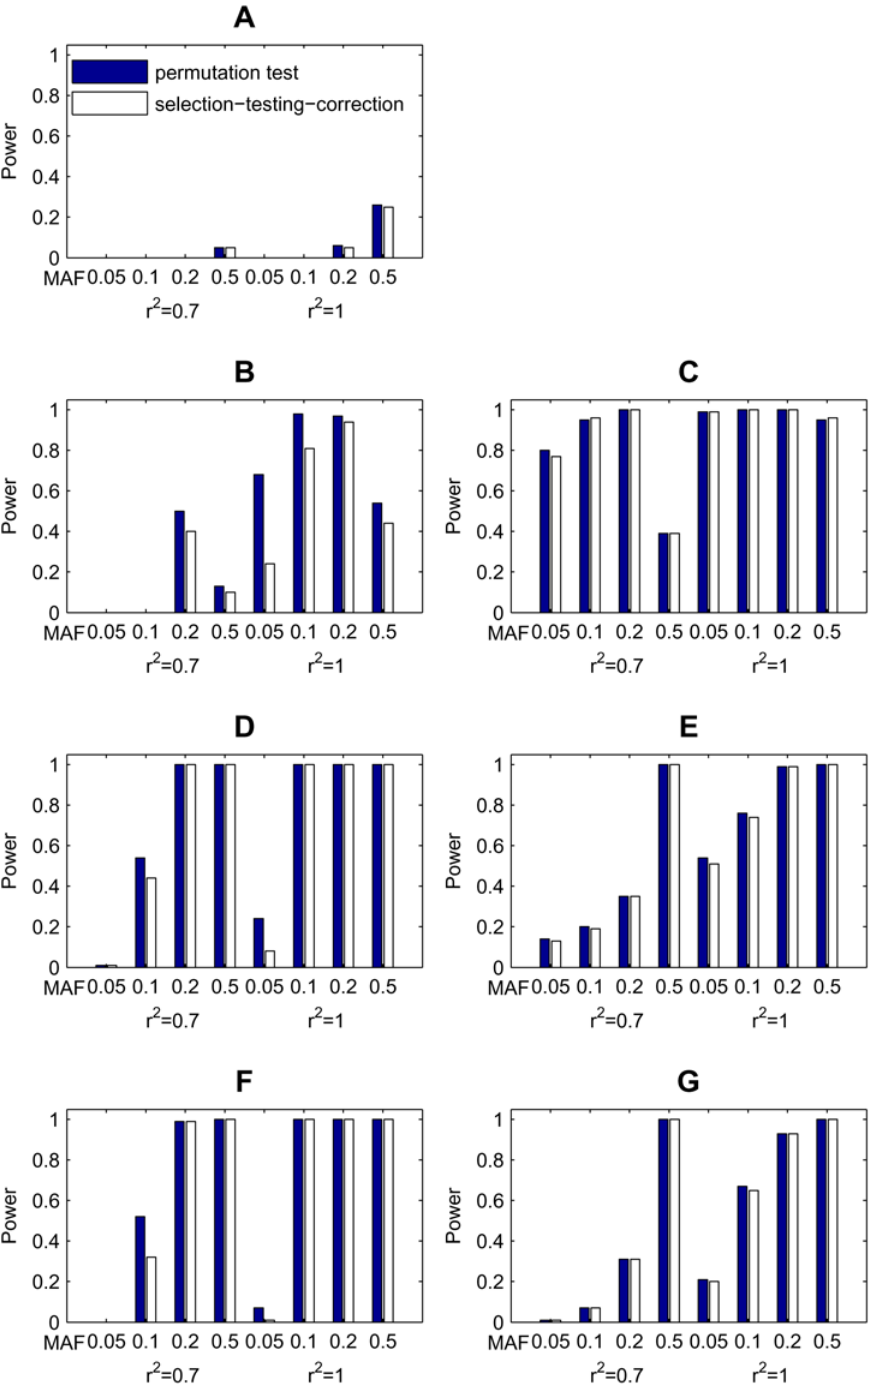
Figure 3. Comparison of the two methods for obtaining statistical significance for epistatic modules.